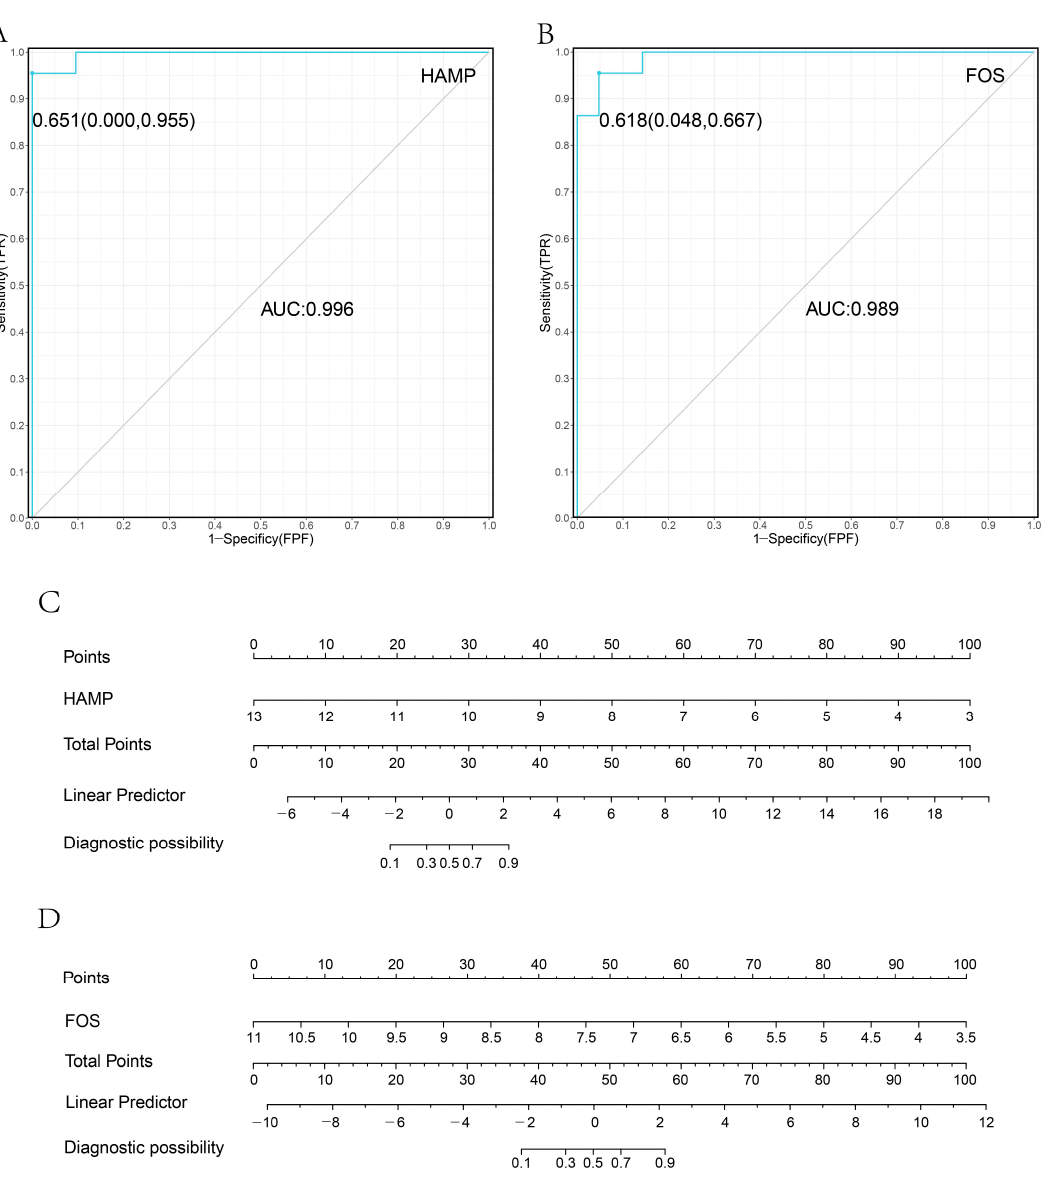
Figure 2. ( A ) ROC curve of HCC diagnosis model of HAMP; ( B ) ROC curve of HCC diagnosis model of FOS; ( C ) nomogram of HCC diagnosis model of HAMP; ( D ) nomogram of HCC diagnosis model of FOS.